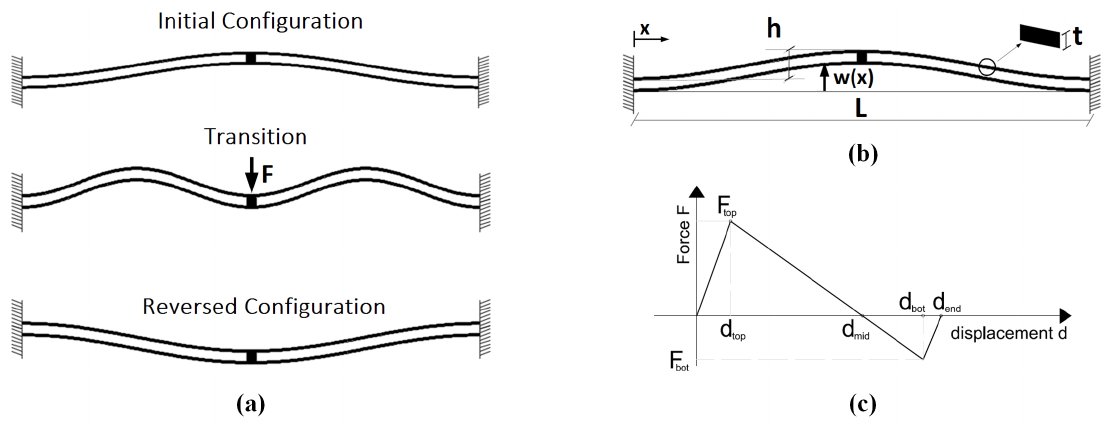
Figure 1. Snap-through buckling (STB) of a double-curved-beam bistable mechanism ( a ), definition of geometrical parameters ( b ), simplified force–displacement curve for a bistable mechanism for Q > 6 [34] ( c